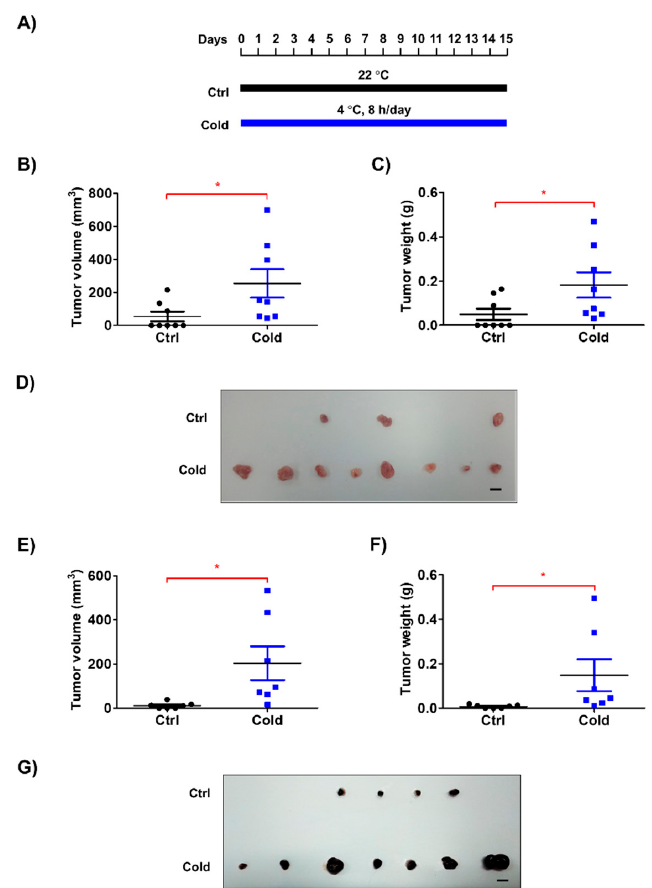
Figure 1. Low ambient temperature accelerated the growth of tumors in an allograft model. ( A ) Lewis lung carcinoma (LLC) cells (1 × 10 5 cells/100 μ L PBS) and B16F10 cells (5 × 10 4 cells/100 μ L PBS) were subcutaneously injected into the dorsum of mice. The mice were housed at 22 °C and mice in the cold group were exposed to 4 °C, 8 h/d for 15 d. ( B , C , E , F ) After 15 d, tumor volume and weight were measured. ( D , G ) Images of tumor samples from the control and cold groups are shown. The bar indicates 1 cm. Data are expressed as the mean ± SD. * p < 0.05 compared to the control group (22 °C). SD, standard deviation; Ctrl, control.